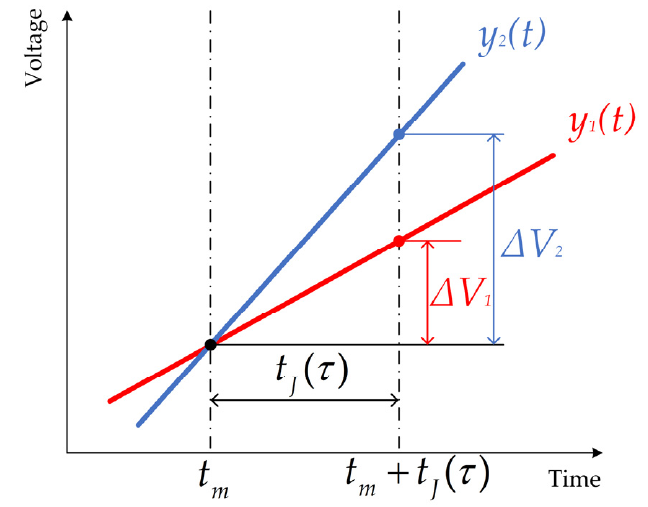
Figure 2. Schematic of the distortion caused by timing jitter. The same conclusion can be obtained that the distortion introduced by timing jitter depends on the slope of the signal and the level of timing jitter. Since UWB impulse radar transmits pulses that are narrow in time, this results in a large change rate of the transmitted signal. At the same time, to improve the SCNR, increasing the transmitted power of the radar is a simple and effective method. This in turn makes the change rate of the transmitted signal and jitter level further increase, worsening the distortion. In the frequency domain, the distortion occupies the entire frequency band and is quite large in the human respiration region. Therefore, it is difficult to perform human respiration signal extraction in the frequency domain without distortion